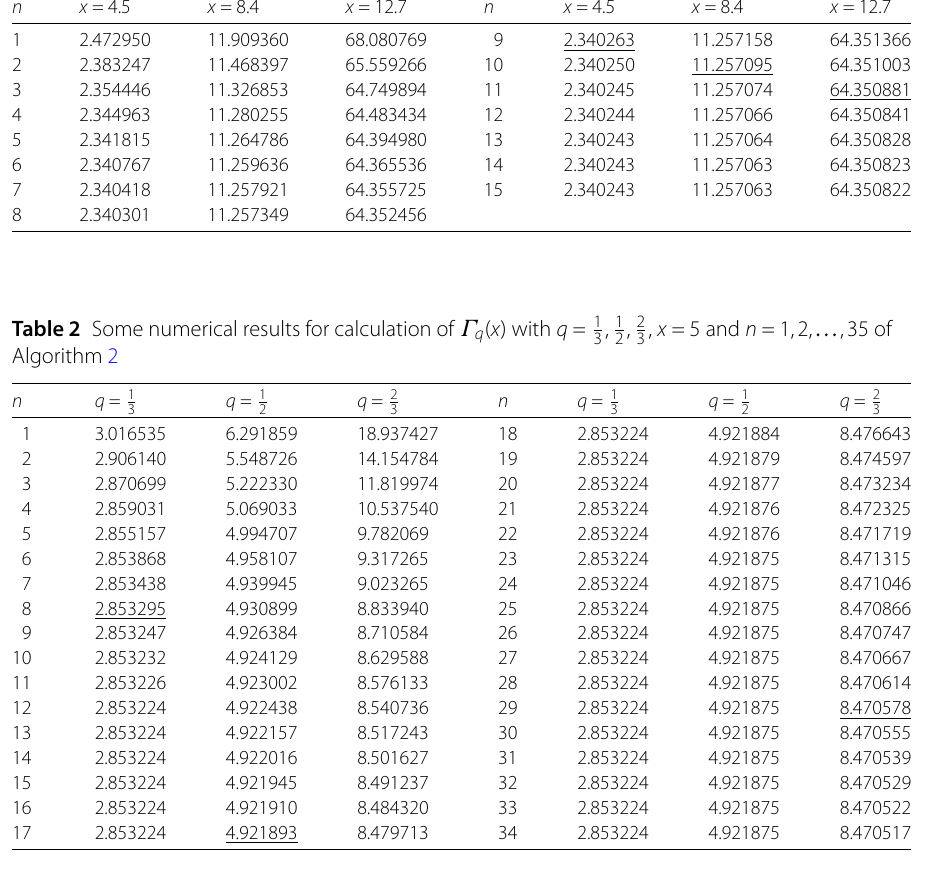
that is constant, x = 4.5,8.4,12.7 3